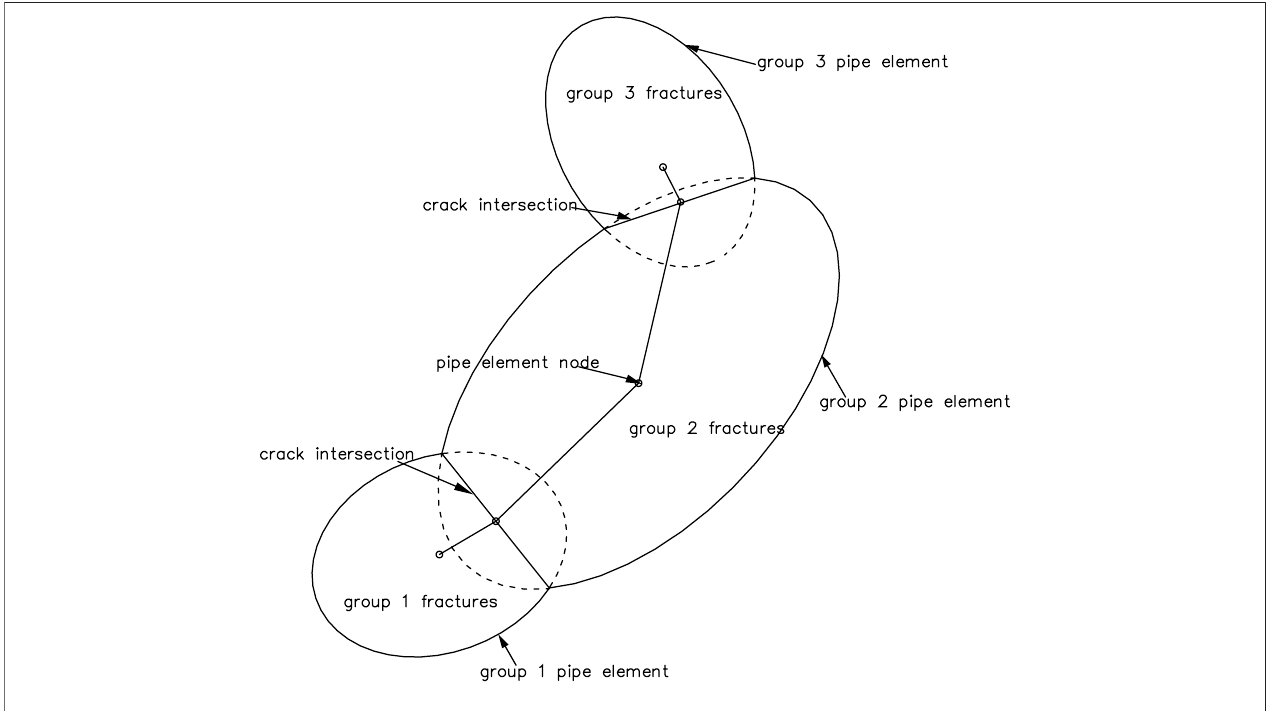
FIGURE 2 | Pipe element of the fracture